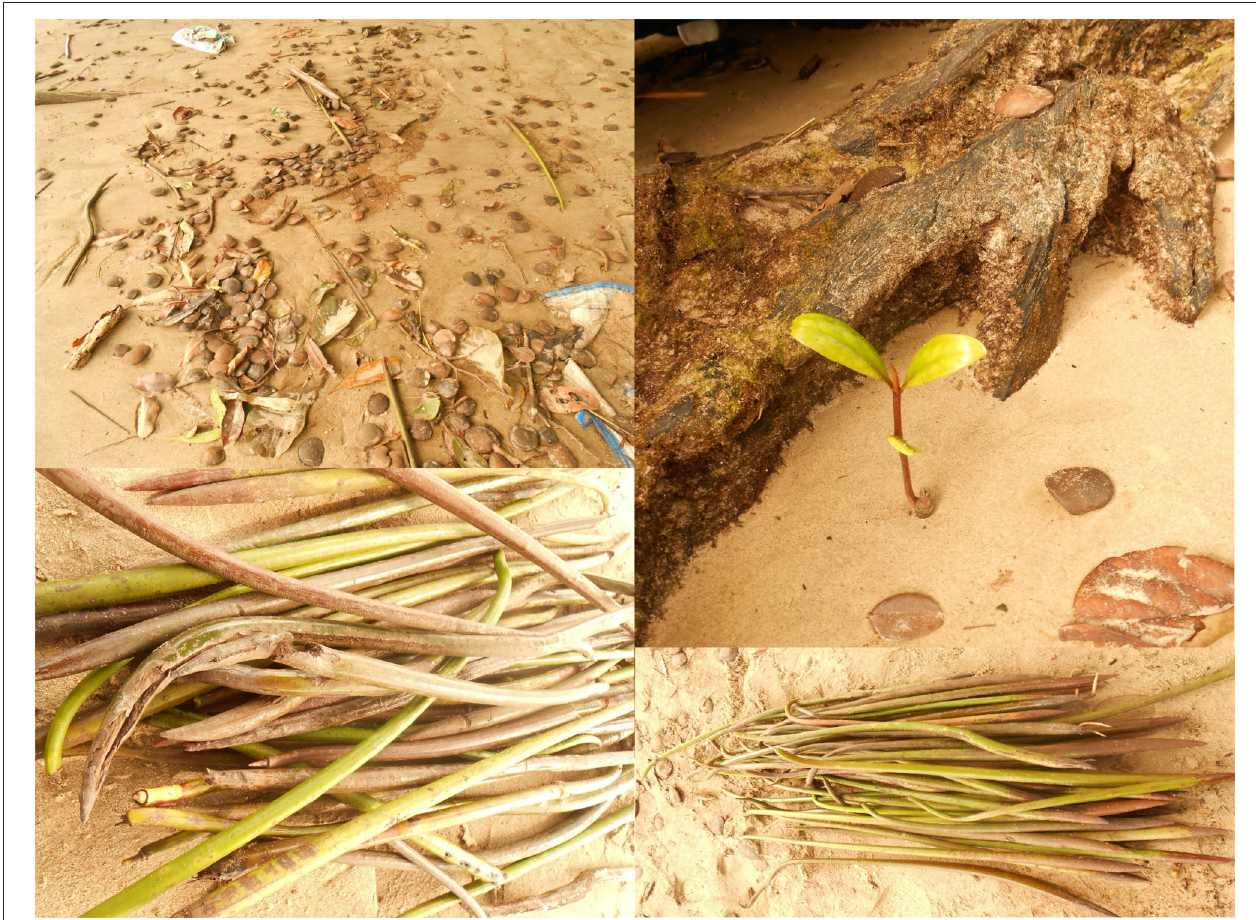
FIGURE 2 | Photos from field surveys and propagules, showing a clearly rooted plant with leaves at the landward edge of the beach. Majority of the propagules were viable, and a few others had structural damages.